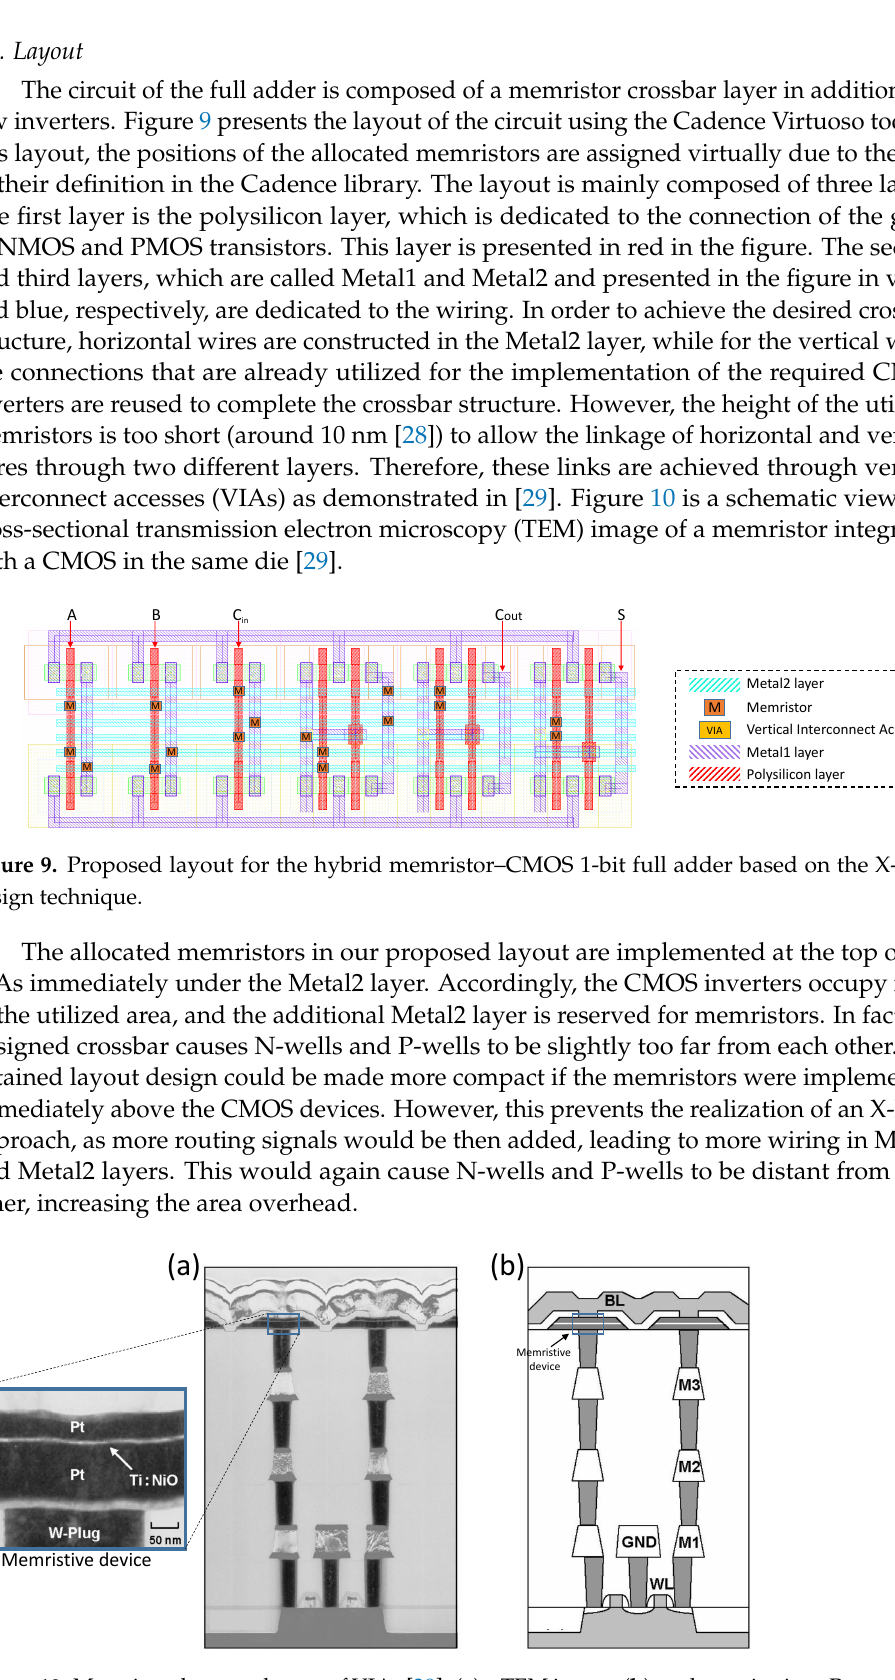
Figure 10. Memristor layer at the top of VIAs [29]: ( a ) a TEM image; ( b ) a schematic view. Reproduced with permission from [29], Copyright 2019,